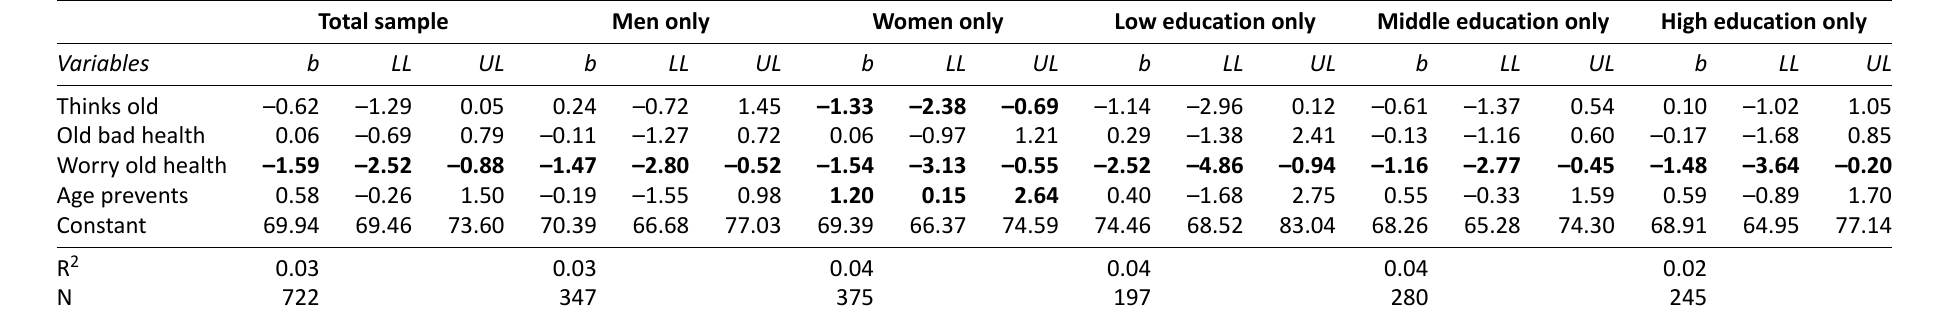
Table A3. Preferred retirement age wave 8 (not truncated/no control variables). Total sample Men only Women only